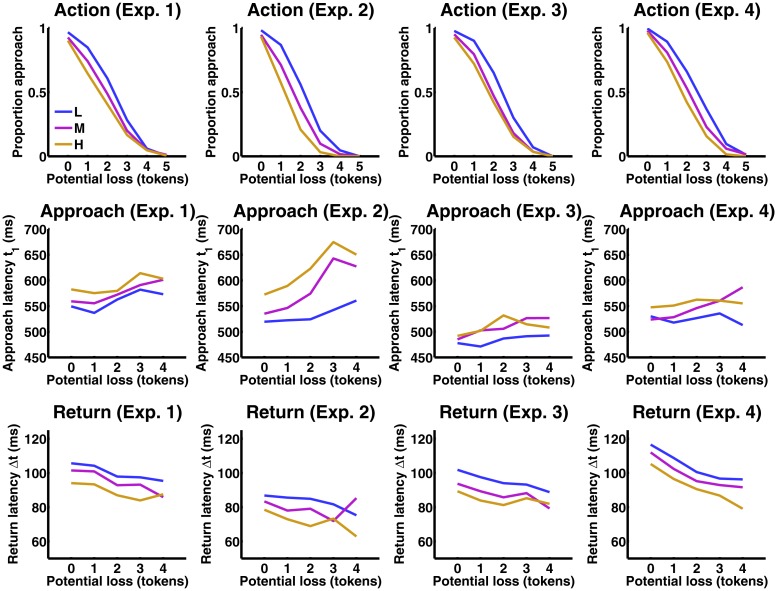
Results from experiments 1–4.The figure shows responses to the possibility to collect the nth token after already having collected (n—1) tokens which constitutes the potential loss. L: low threat. M: medium threat. H: high threat. Action: Percentage of epochs in which the player chose to collect at least the nth token. One can see that on the first token, i. e. when there is no potential loss involved, players almost always approach. After collecting increasingly many tokens, approach choices are reduced, and they are also reduced by higher threat level, (i. e. probability of loss). Approach and return latencies: Because the players rarely approached after collecting 5 tokens, approach latency is only shown up to a potential loss of 4 tokens. As the data are unbalanced, mean approach latencies were estimated in a linear mixed effects model (see Model and Methods). Approach latencies are increased both by increasing potential loss (i. e. number of already collected tokens) and by increasing threat level (i. e. probability of loss). The reverse pattern is seen for return latencies.